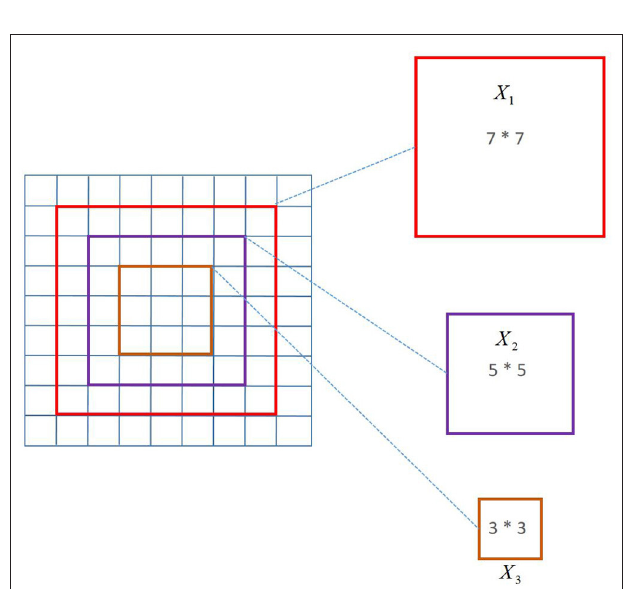
FIGURE 2 | Schematic diagram of multi-scale and multi-layer interactive feature fusion. parameters (weight and offset), i.e., continuously learning the